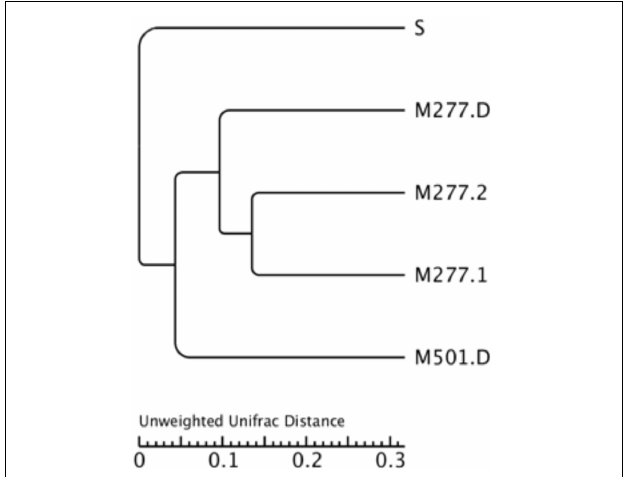
FIGURE 8 | UPGMA clustering tree based on